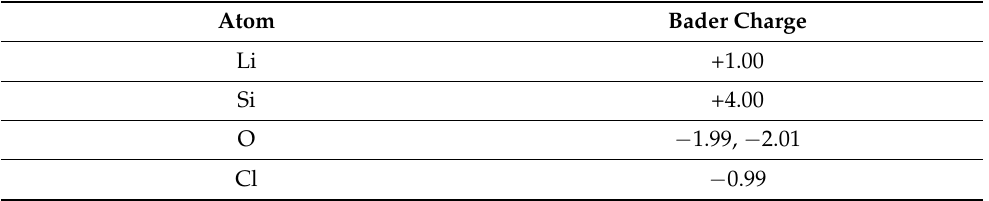
Table 2. Calculated Bader charges on each atom present in the bulk Li 6 SiO 4 Cl 2.